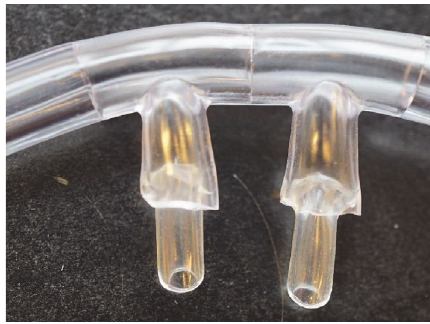
Figure 3: Modified reservoir cannula. Small nasal prongs were attached to the adult-sized prongs to accommodate the nares of the toddler and small child airway